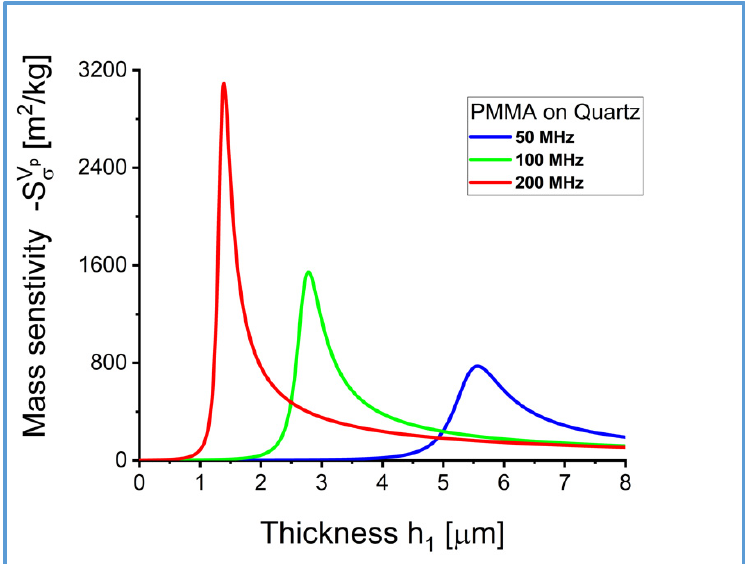
(cid:3097)(cid:3049) (cid:3291) (cid:3427) (cid:2) (cid:3) v p m 2 kg (cid:3415) (cid:3431) for Love surface waves propagating in wave- m 2 /kg for Love surface waves propagating in σ